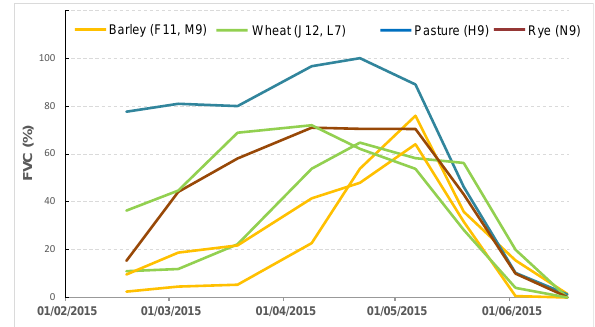
Figure 4. FVC evolution for the seven plots clustered by type of crop. K10 is not shown.